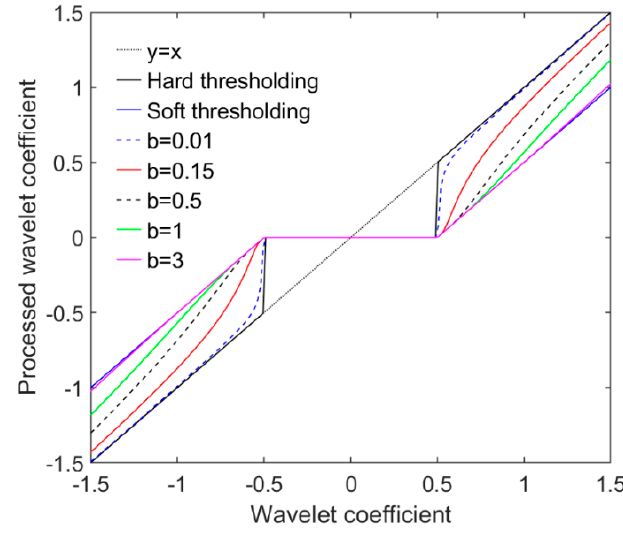
Figure 1. Comparison of threshold function characteristics.